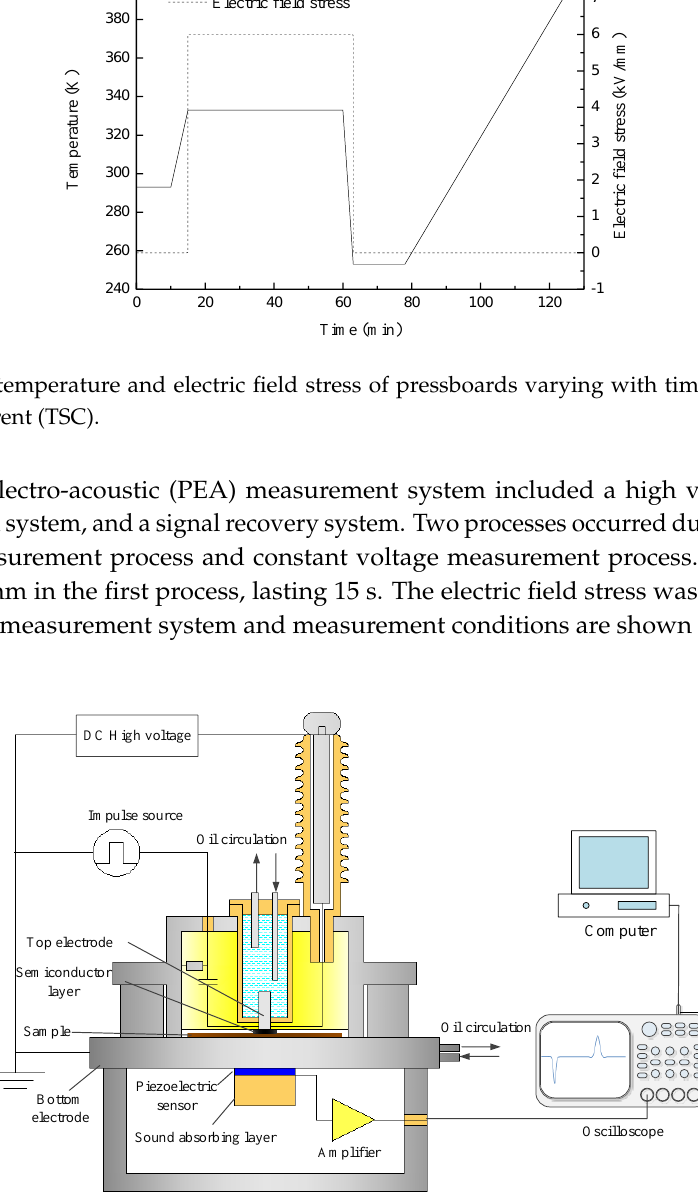
Figure 5. The space charge distribution measurement system.